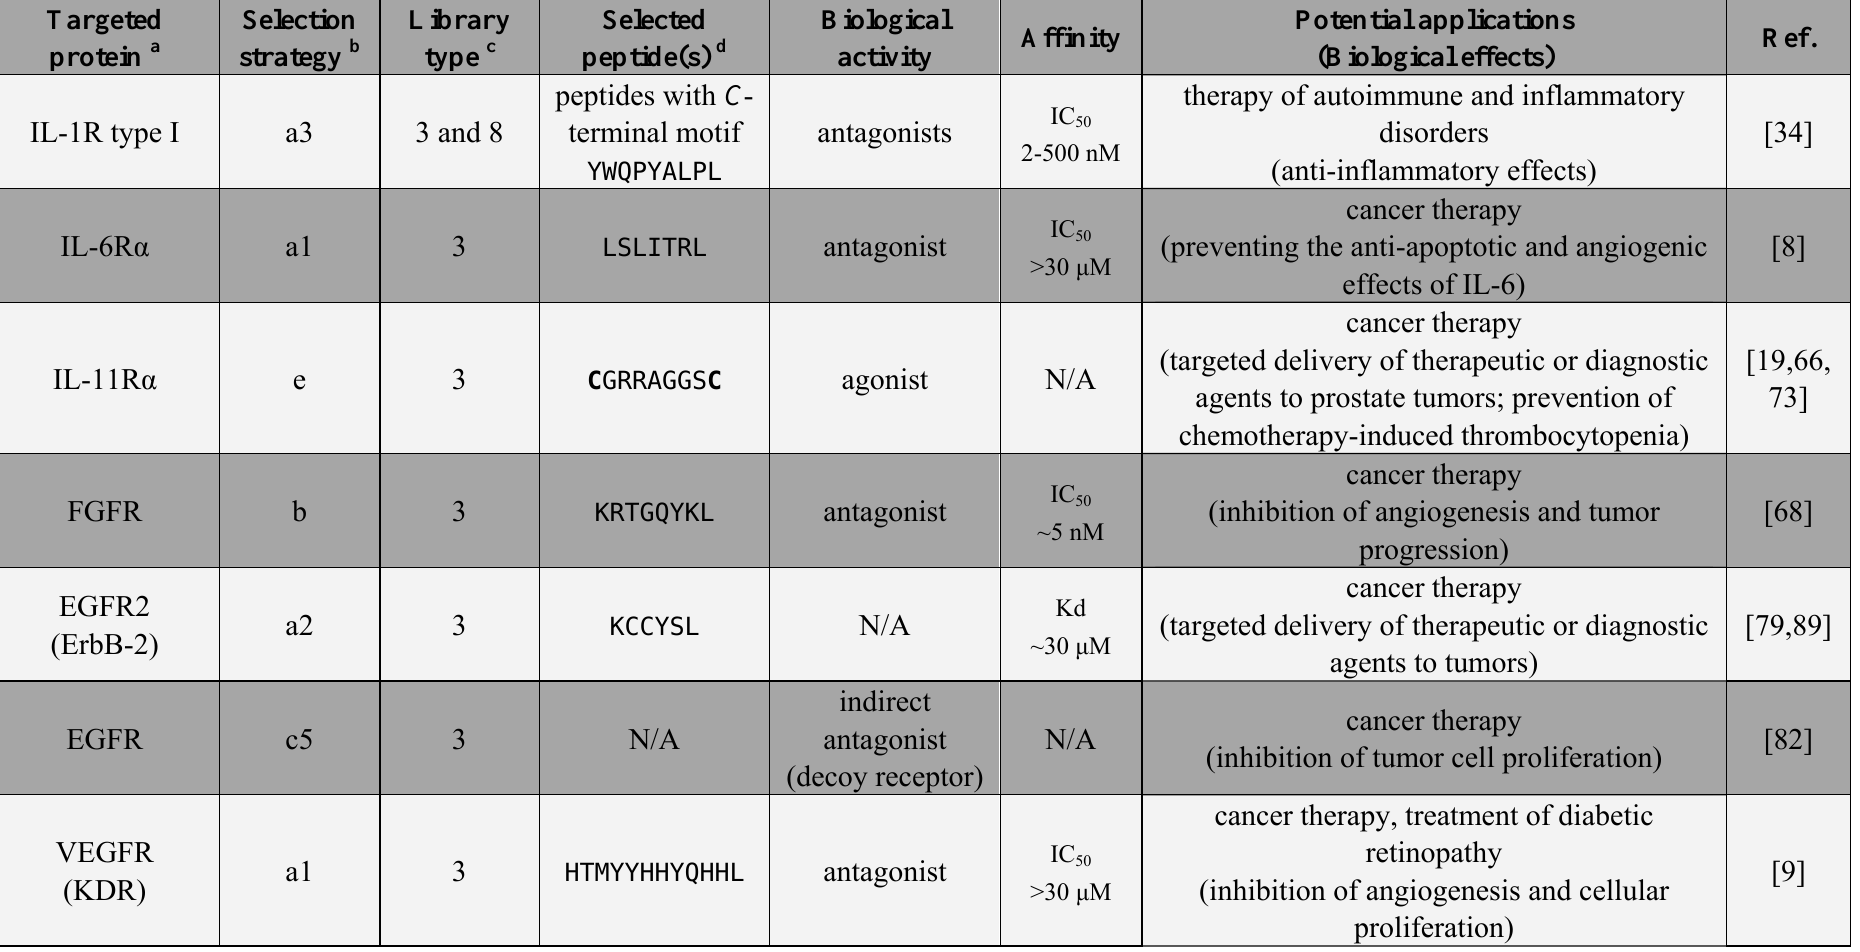
Table 1. Selected reports of peptides identified from phage-displayed libraries that home to membrane-embedded proteins. If the exact nature of targeted protein on primary cell cultures or tissue xenografts was not determined, it is listed as “unknown” followed by cell culture or tissue type in square brackets. N/A, not